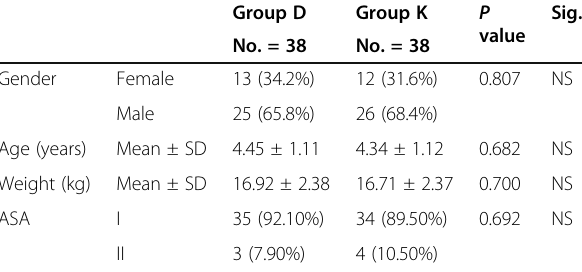
Table 5 Comparison between group D and group K as